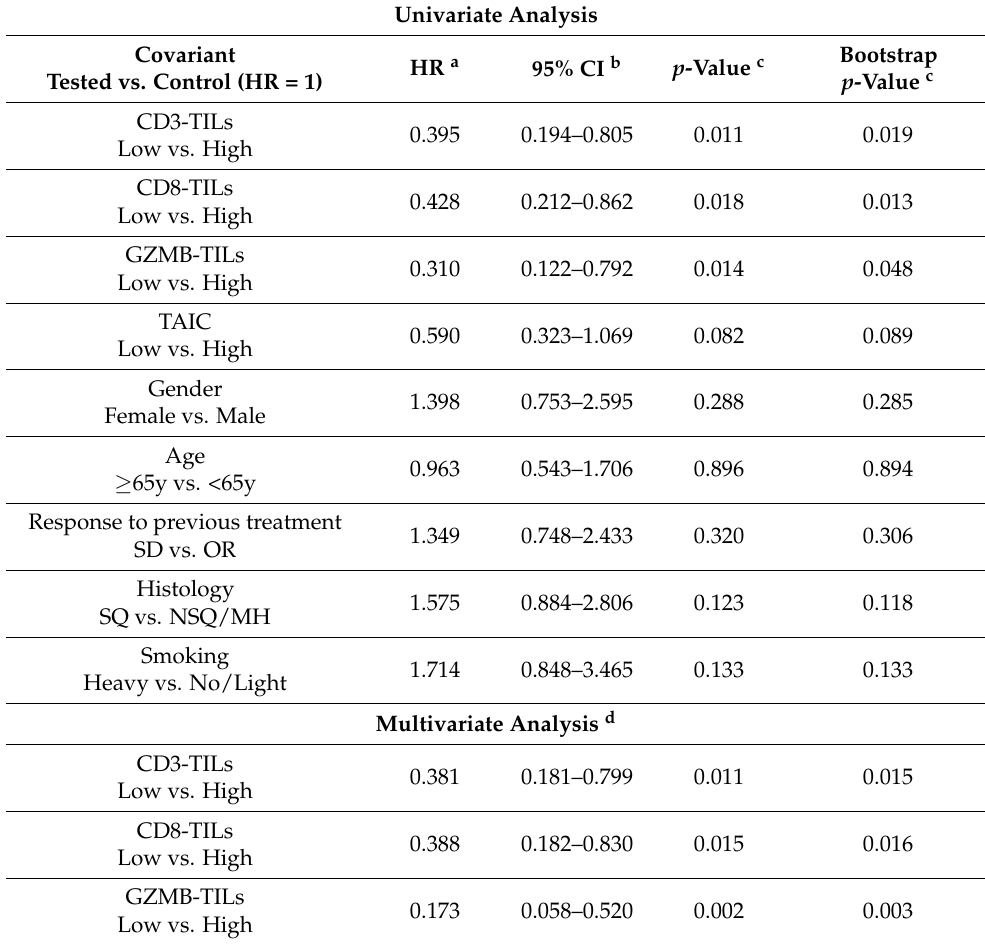
Table 2. Univariate and multivariate Cox regression analysis of OS in the Vx-001